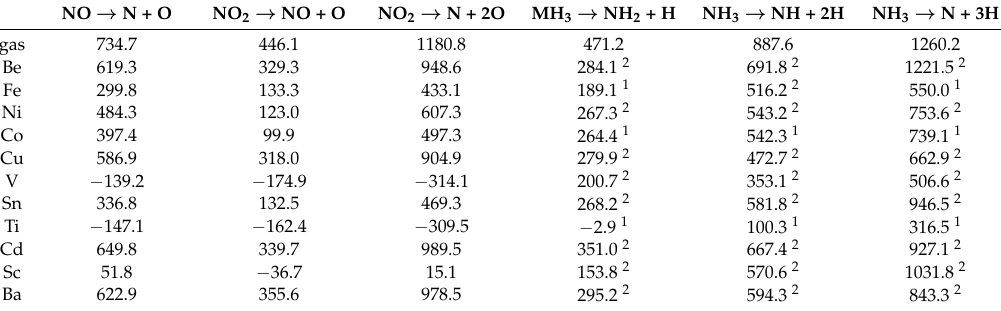
Table 3. The dissociative adsorption energy ∆ E ads-sep ’ (kJ mol − 1 ) of nitrogen-containing compounds on selected M-HKUST-1.